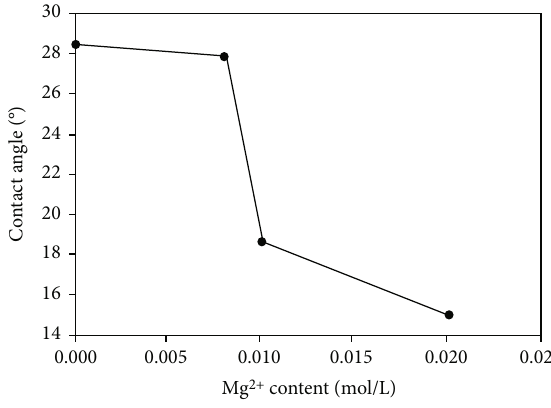
Figure 10: Relationship between Mg 2+ content and emulsion contact angle.